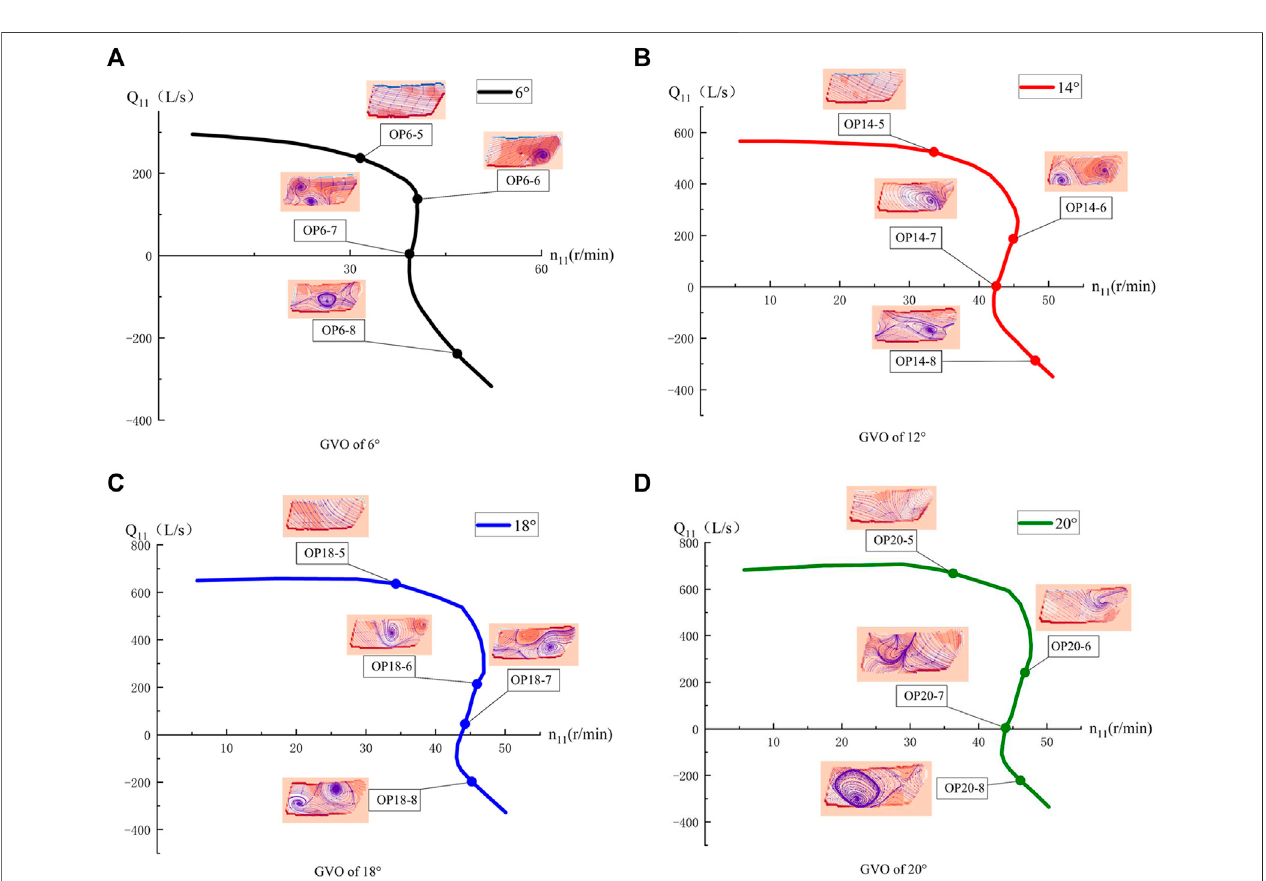
FIGURE 12 | Test results are on the S curve. (A) GVO of 6 ° (B) GVO of 12 ° (C) GVO of 18 ° (D) GVO of 20 ° .